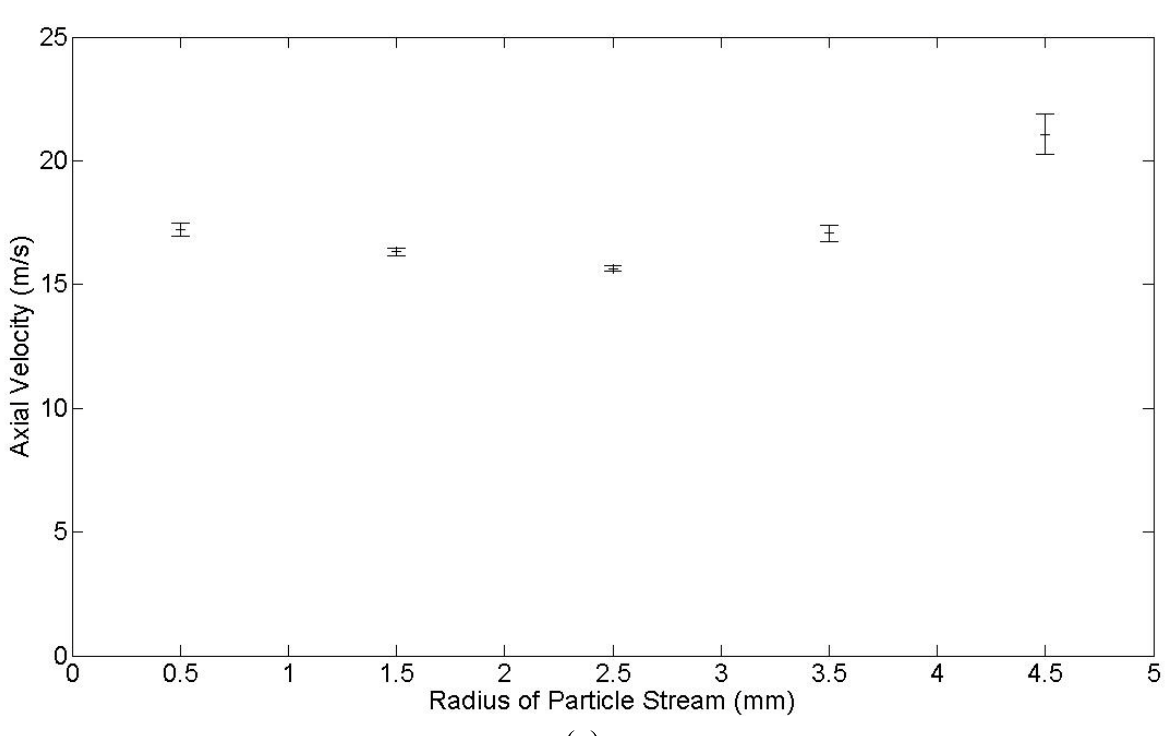
Figure 20. Experiment 1: Numerical simulation of two phase flow. The particle ( a ) axial and ( b ) radial velocities at 10 cm from the origin of the annular air jet averaged over 1 mm radial